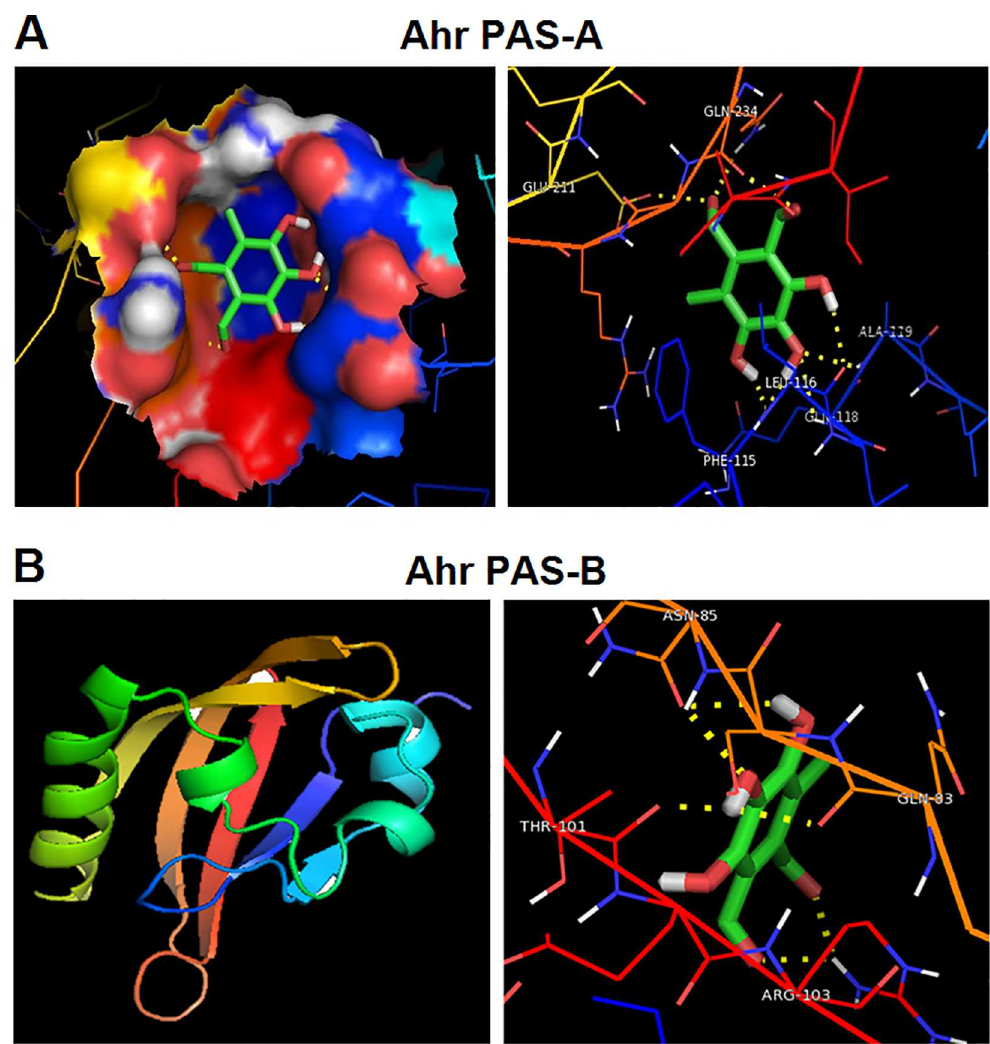
Fig 1. The in silico docking of Flavipin binding potential to human Ahr Pas-A and Pas-B Ligand domain. (A) Flavipinbinds to Ahr PAS-A at Phe115, Leu116and Ala119. (B) The Flavipininteracted with the four active residuesof Ahr PAS-B at Gln83, Asn85, Thr101 and Arg103. The yellow-dotted lines indicatesthe